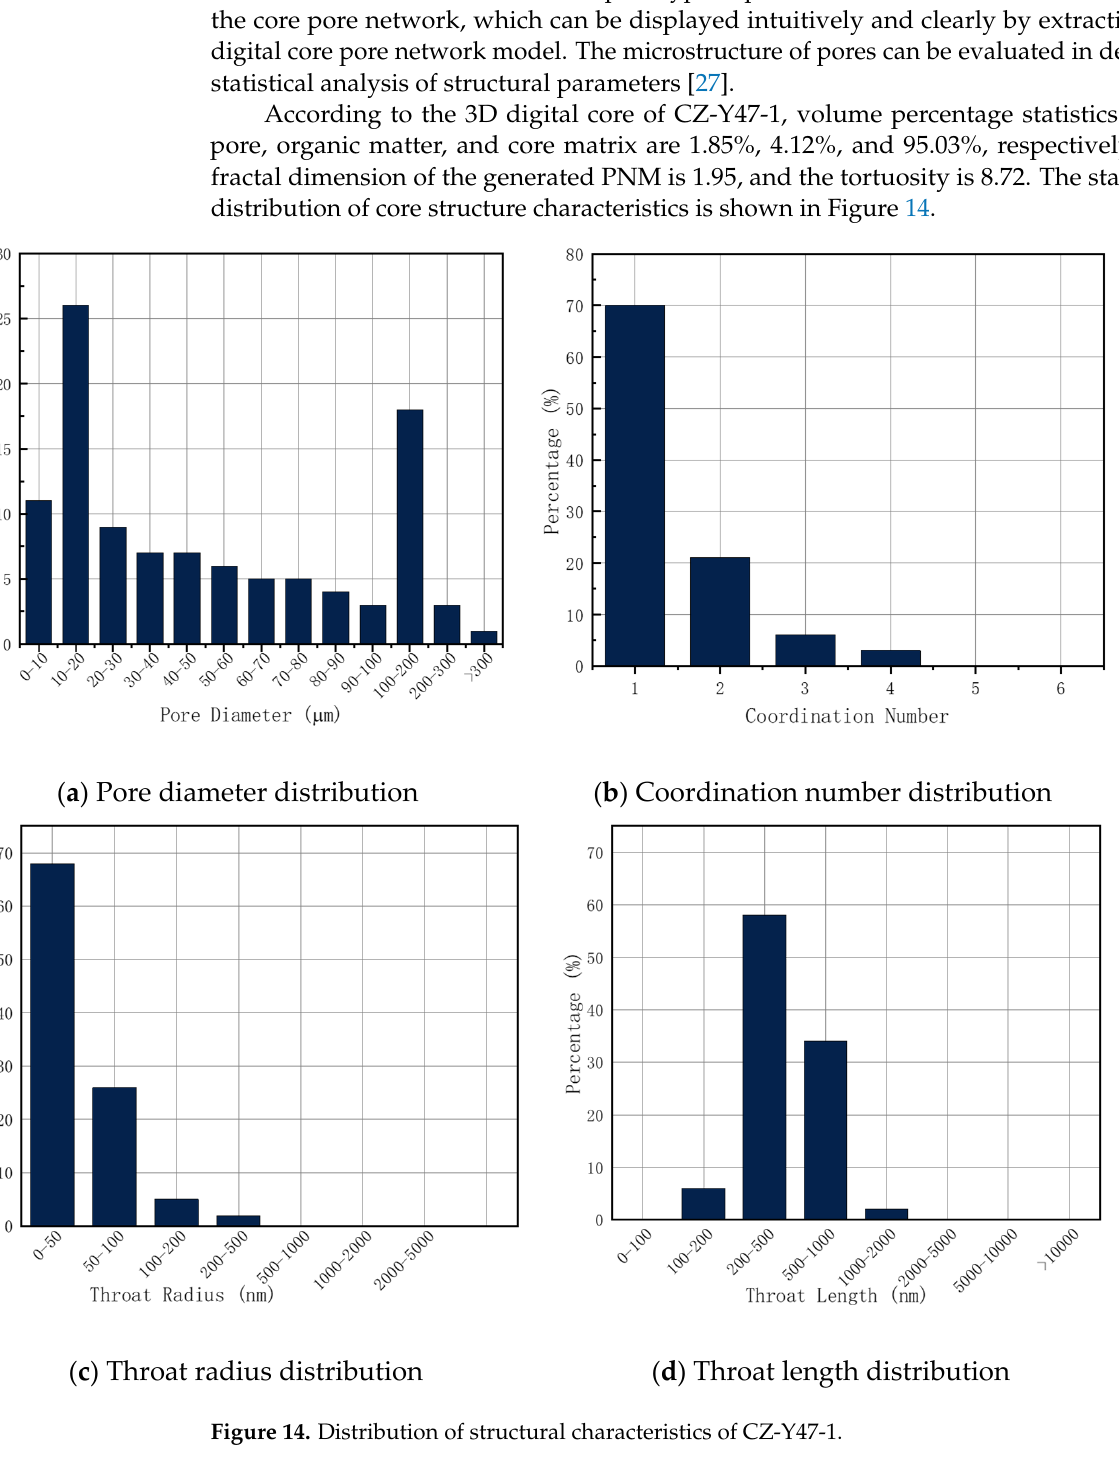
Table 4. Pore network parameters (unit, volume: ml; radius: